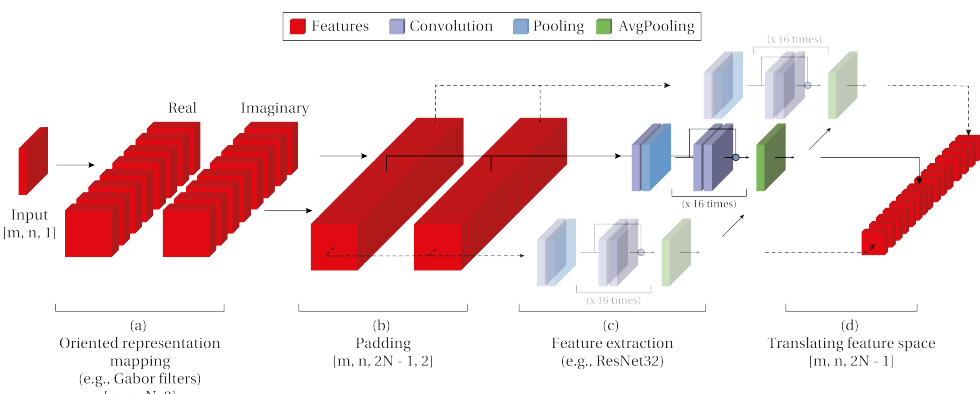
Figure 5. The backbone feature extraction is applied to each filter of the oriented feature space. ResNet used as backbone example. Output is a translating feature space. (Image blocks with N =